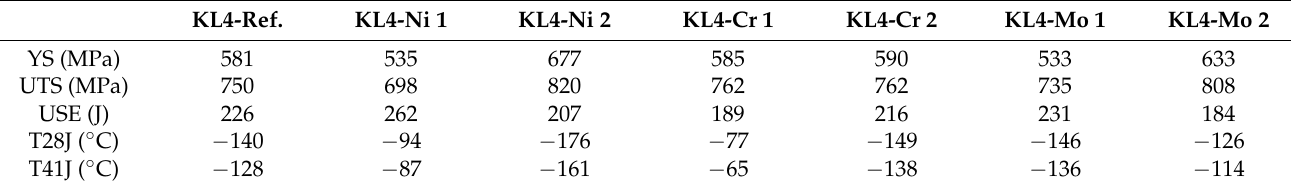
Table 6. Tensile and Charpy test results of the test steel